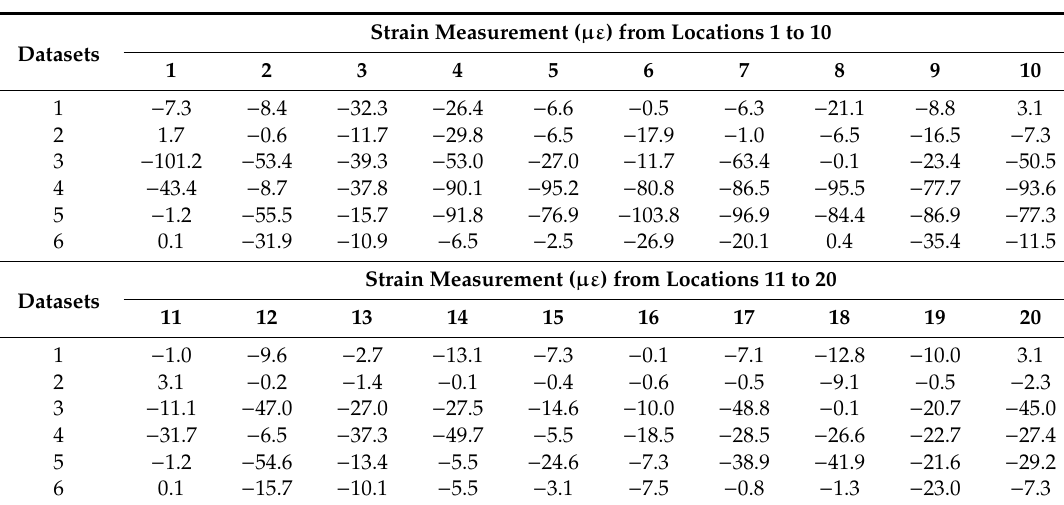
Table 2. Sample database of strain